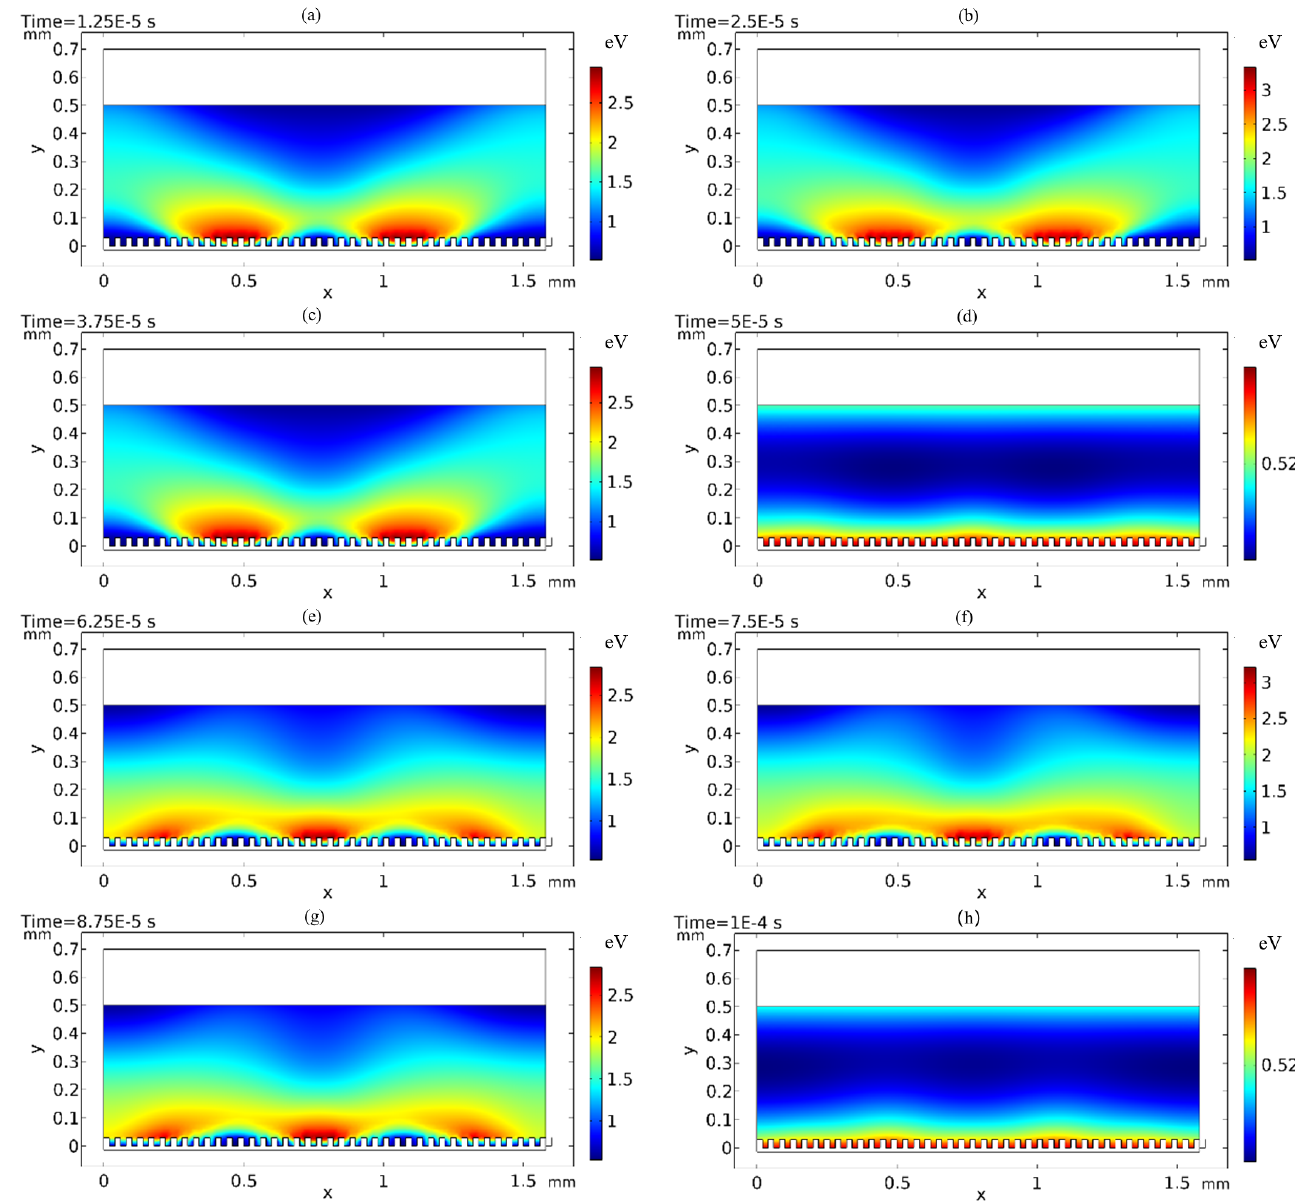
Figure 11. Evolution of the electron temperature in the coplanar CPED discharge device at different times: ( a ) 1/8 T, ( b ) 1/4 T, ( c ) 3/8 T, ( d ) 1/2 T, ( e ) 5/8 T, ( f ) 3/4 T, ( g ) 7/8 T, ( h ) 1 T.